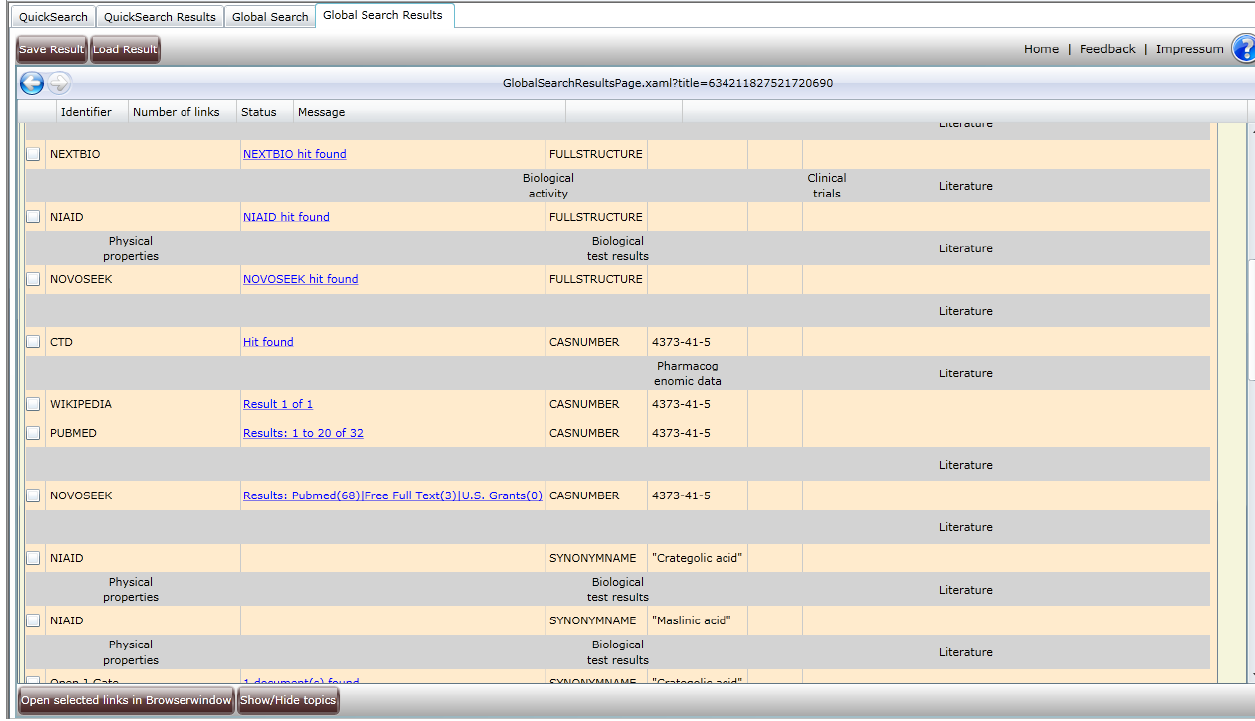
Figure 3. Global Search Result Page of the combined CAS registry number synonym, and structure search for maslinic